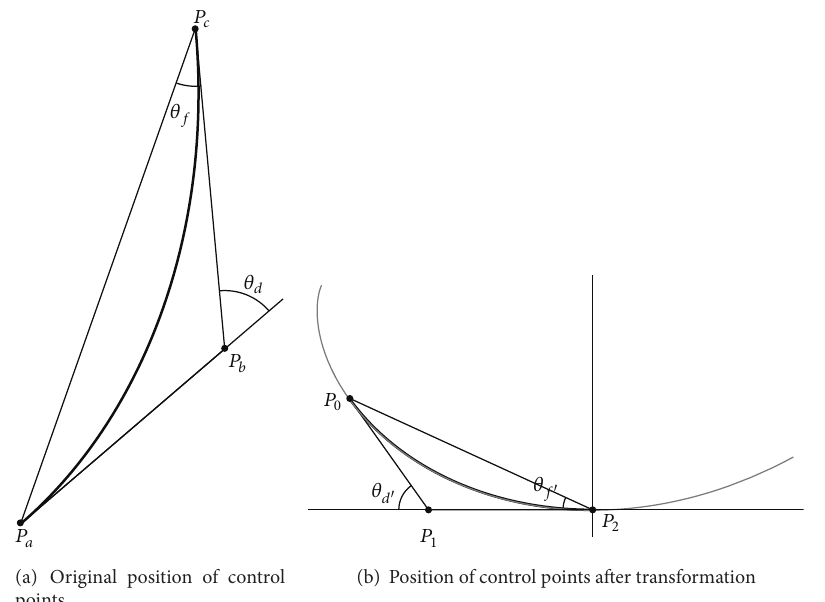
Figure 2: The configuration of triangle consists of three control points for case 𝛼 > 1 . The curve inside the triangle represents the generated LAC